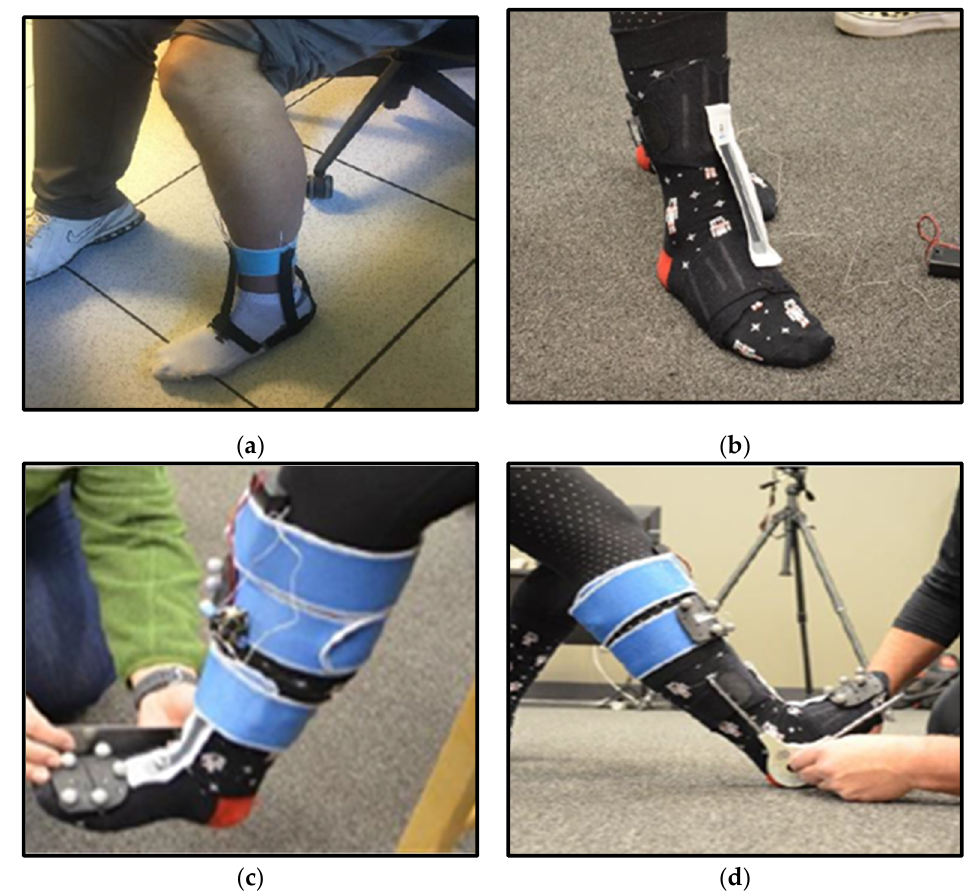
Figure 8. Early attempts at using Velcro to attach sensors to the sock. ( a ) The initial attempt at mounting SRS with Velcro, ( b ) SRS mounting SRS to ankle straps with Velcro on SRS only, ( c ) SRS mounted with motion capture clusters and sensing module, and ( d ) SRS mounted while the foot is being calibrated to the neutral position.